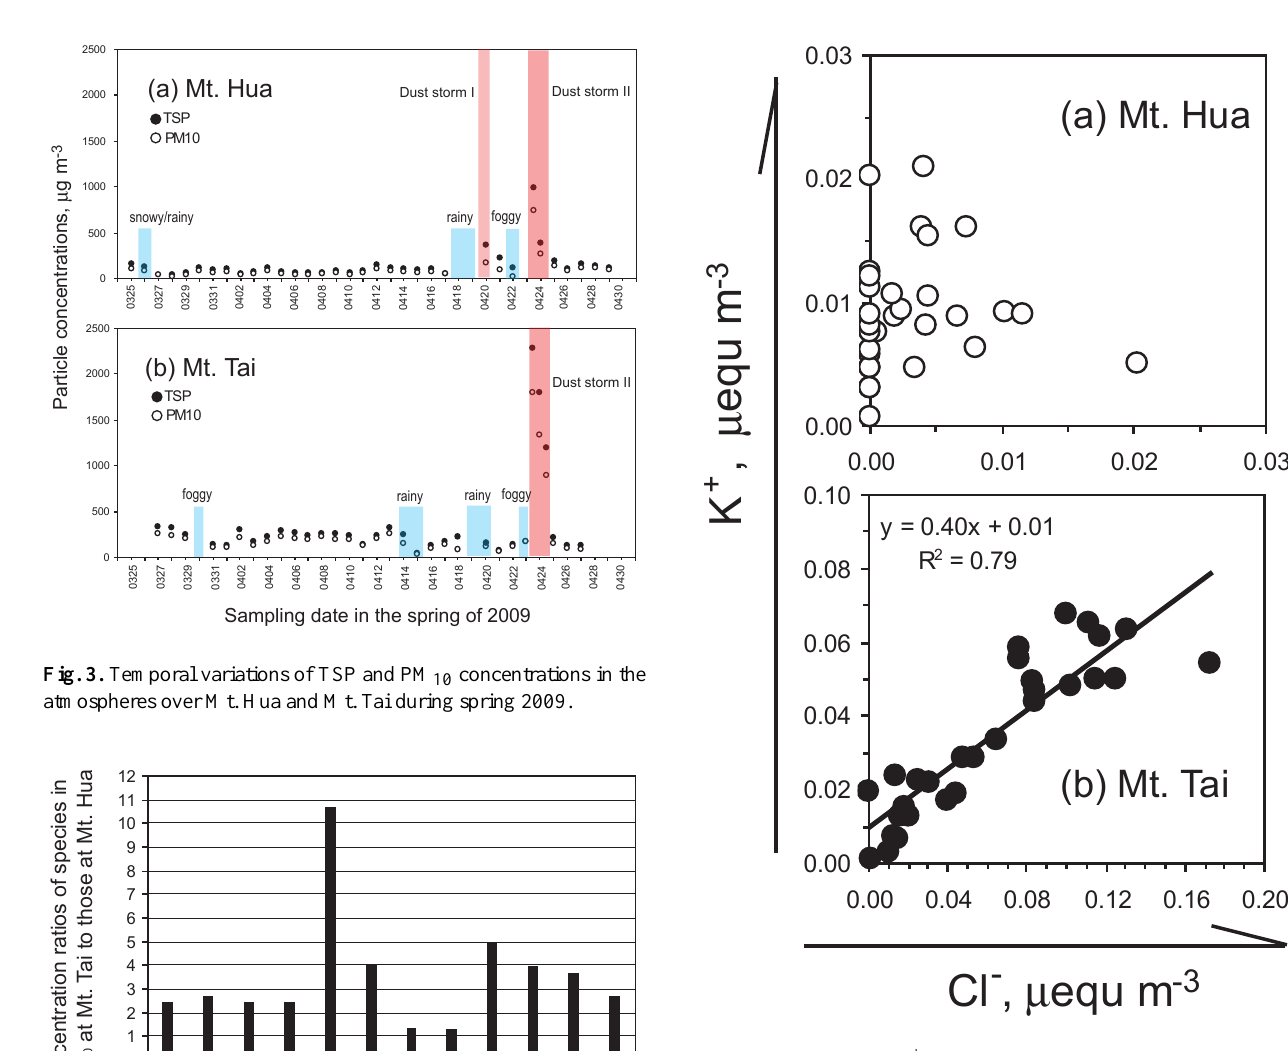
Fig. 4. Difference in the concentrations of species in PM 10 be- tween Mt. Hua and Mt. Tai during the non-dust storm period in Figure 4. Difference in the concentraitions of species in PM10 between Mt. Hua and Mt. Tai spring 2009. during the non-dust storm period in spring 2009